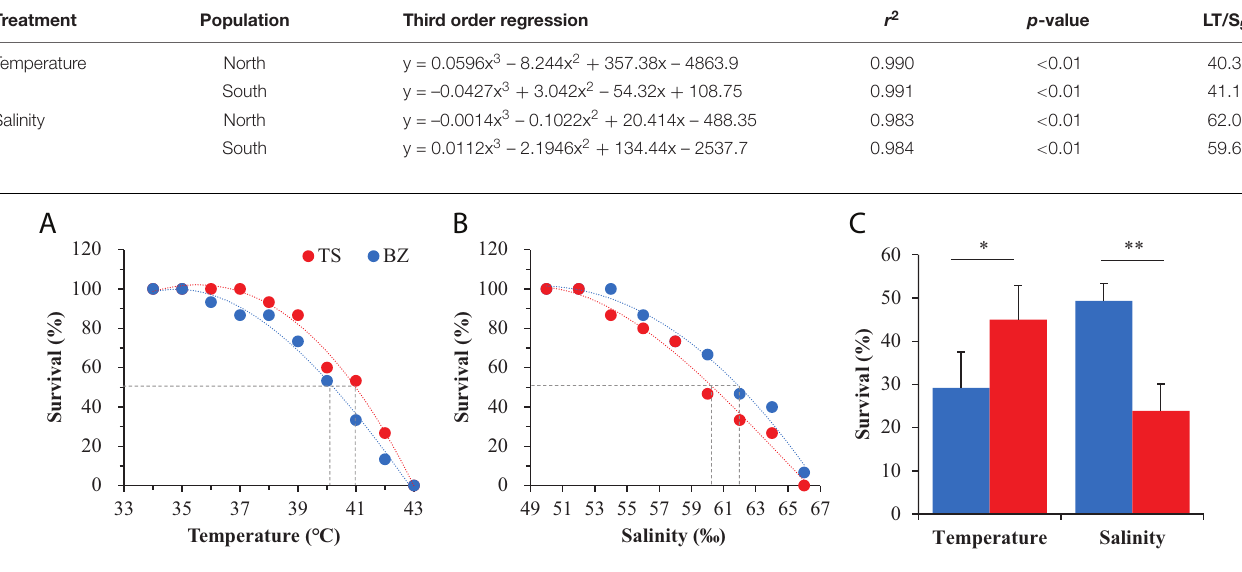
TABLE 1 | LT 50 , LS 50 , and third order regression equations for the northern (BZ) and southern (TS) oysters cultured in their native habitat when exposed to higher temperature and salinity. Treatment